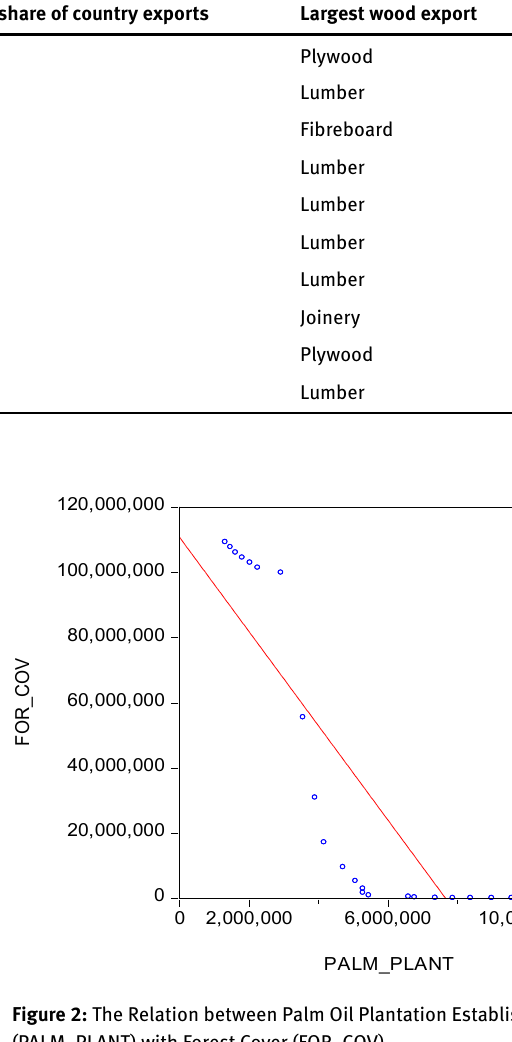
Figure 2: The Relation between Palm Oil Plantation Establishment (PALM_PLANT) with Forest Cover (FOR_COV)